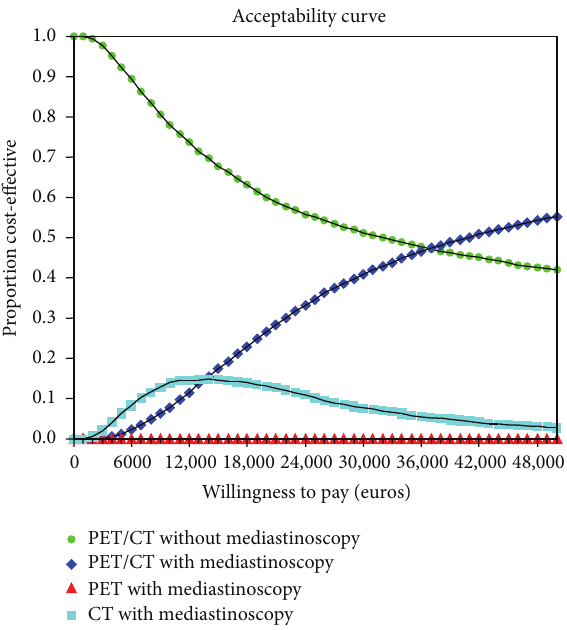
Figure 5: Cost-effectiveness acceptability